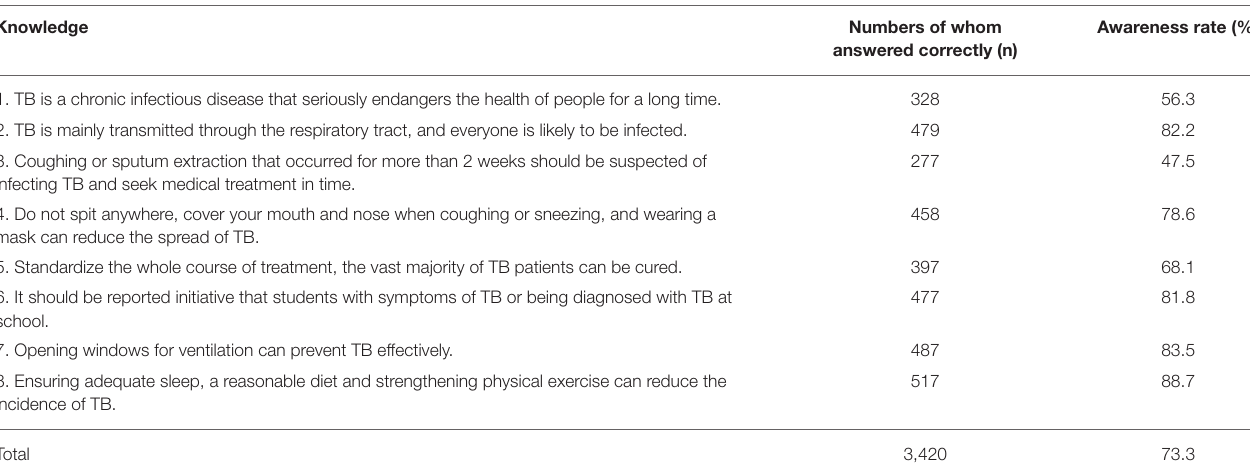
TABLE 3 | The cognition about the eight core knowledge of TB among freshmen ( n =